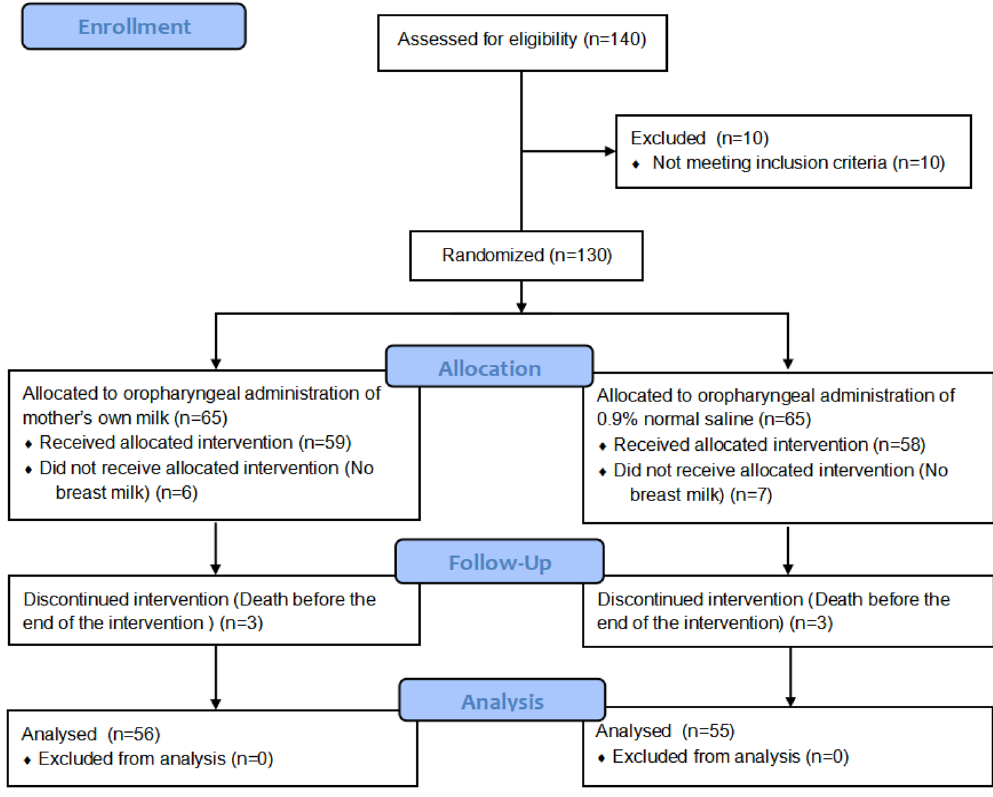
Figure 1. Flow diagram of the study